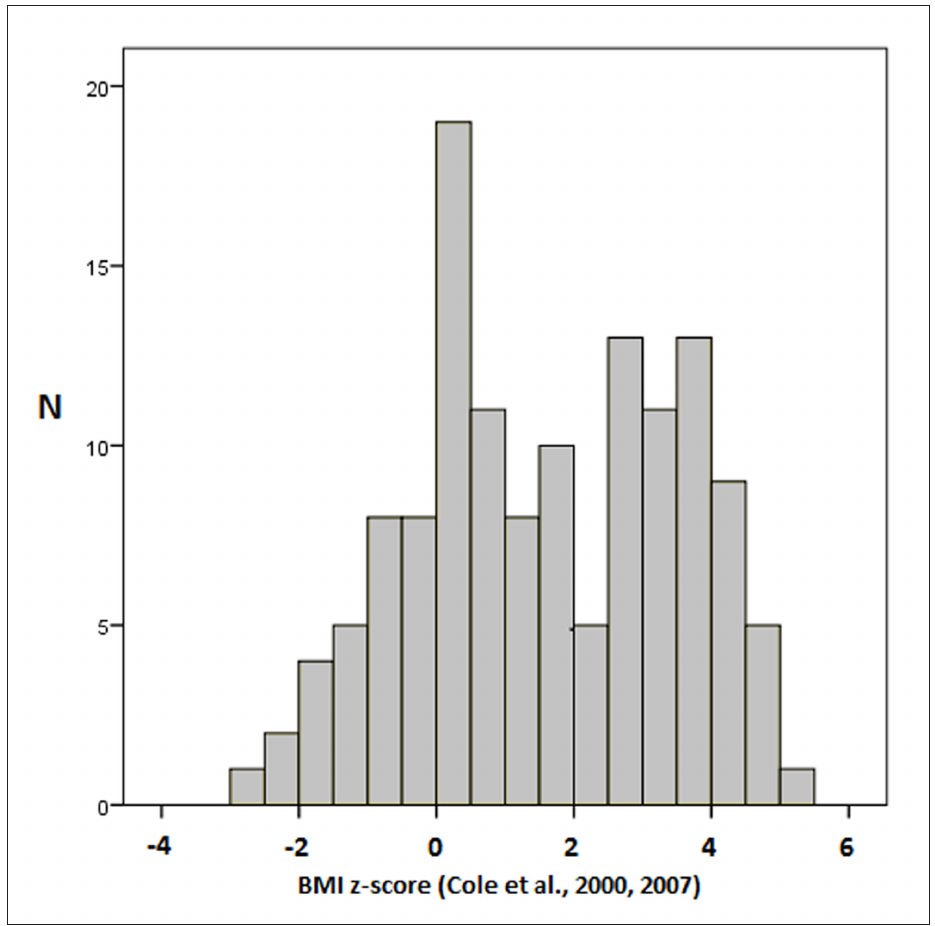
Figure 2: BMI z-score Distribution of Recruited Population (8–18 Years